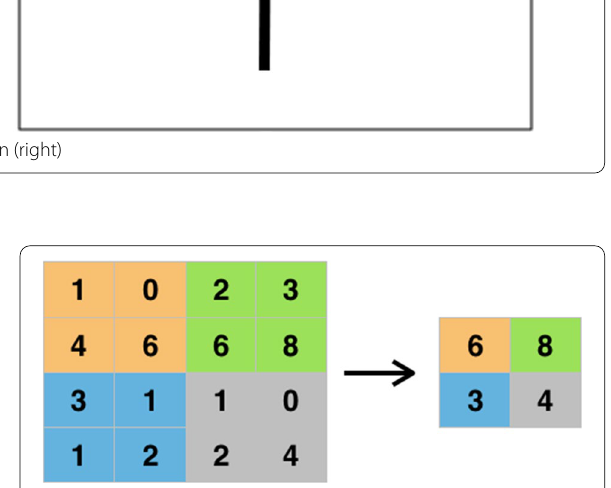
Fig. 15 Max‑pooling applied to a feature map, reducing its